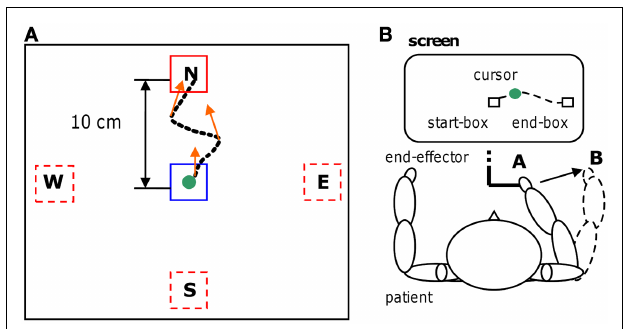
FIGURE 1 | Motor-training . Four targets “center-out” task (A) with an example of a trajectory and some assisted-force-feedback vectors (orange arrows); physical representation (B) of the reaching task.The trajectory is shown for clarity, but during the motor task was never